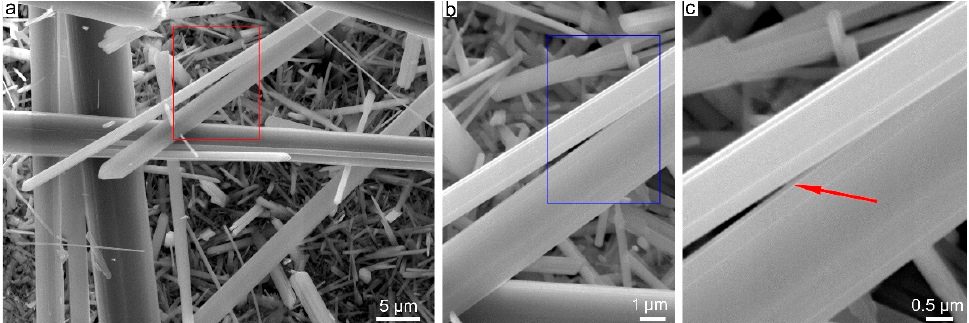
Figure 6. Secondary electron SEM images. ( a ) Longitudinal splitting into thinner fibrils from larger fiber of Ni-doped tremolite (red rectangle) run TN8 (800 ◦ C, 2.4 kbar, 16 day); ( b ) enlargement of the red rectangle of Figure ( a ); ( c ) enlargement of the blue rectangle of Figure ( b ), note the fiber splitting indicated by the red arrow.